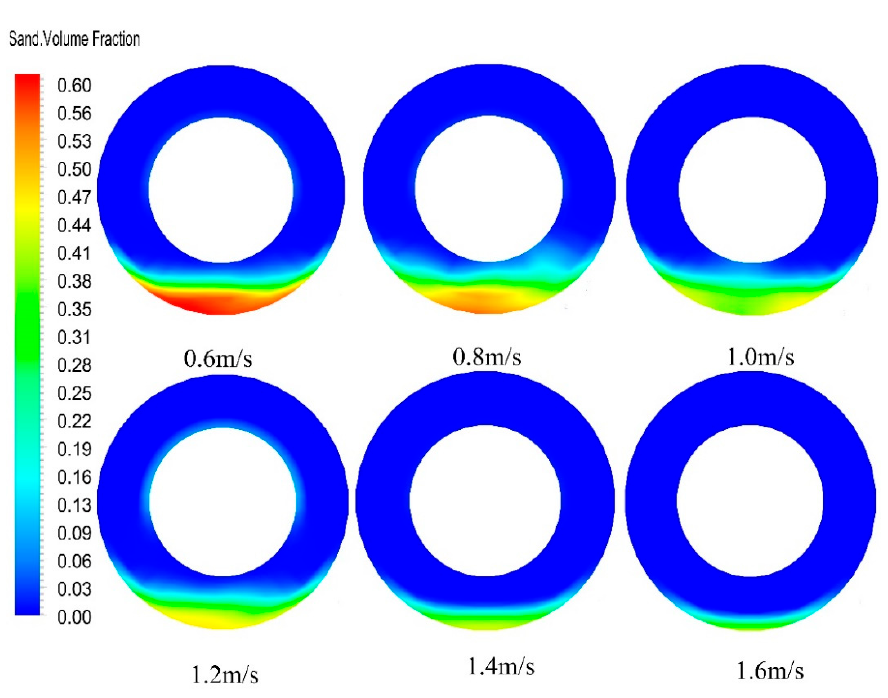
Figure 11. The contour of the effect of displacement on the volume fraction.